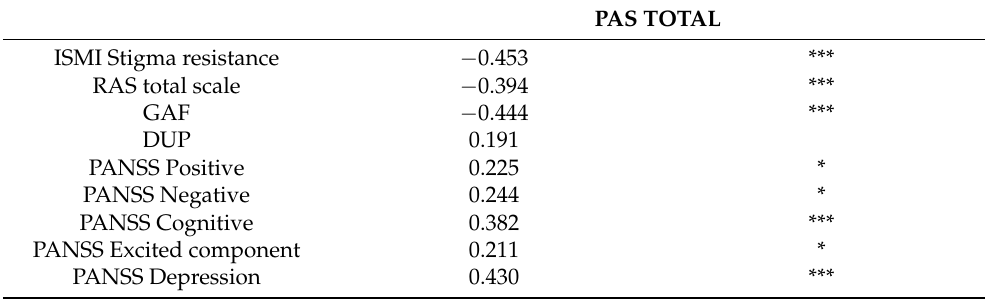
Table 2. Correlation Matrix.